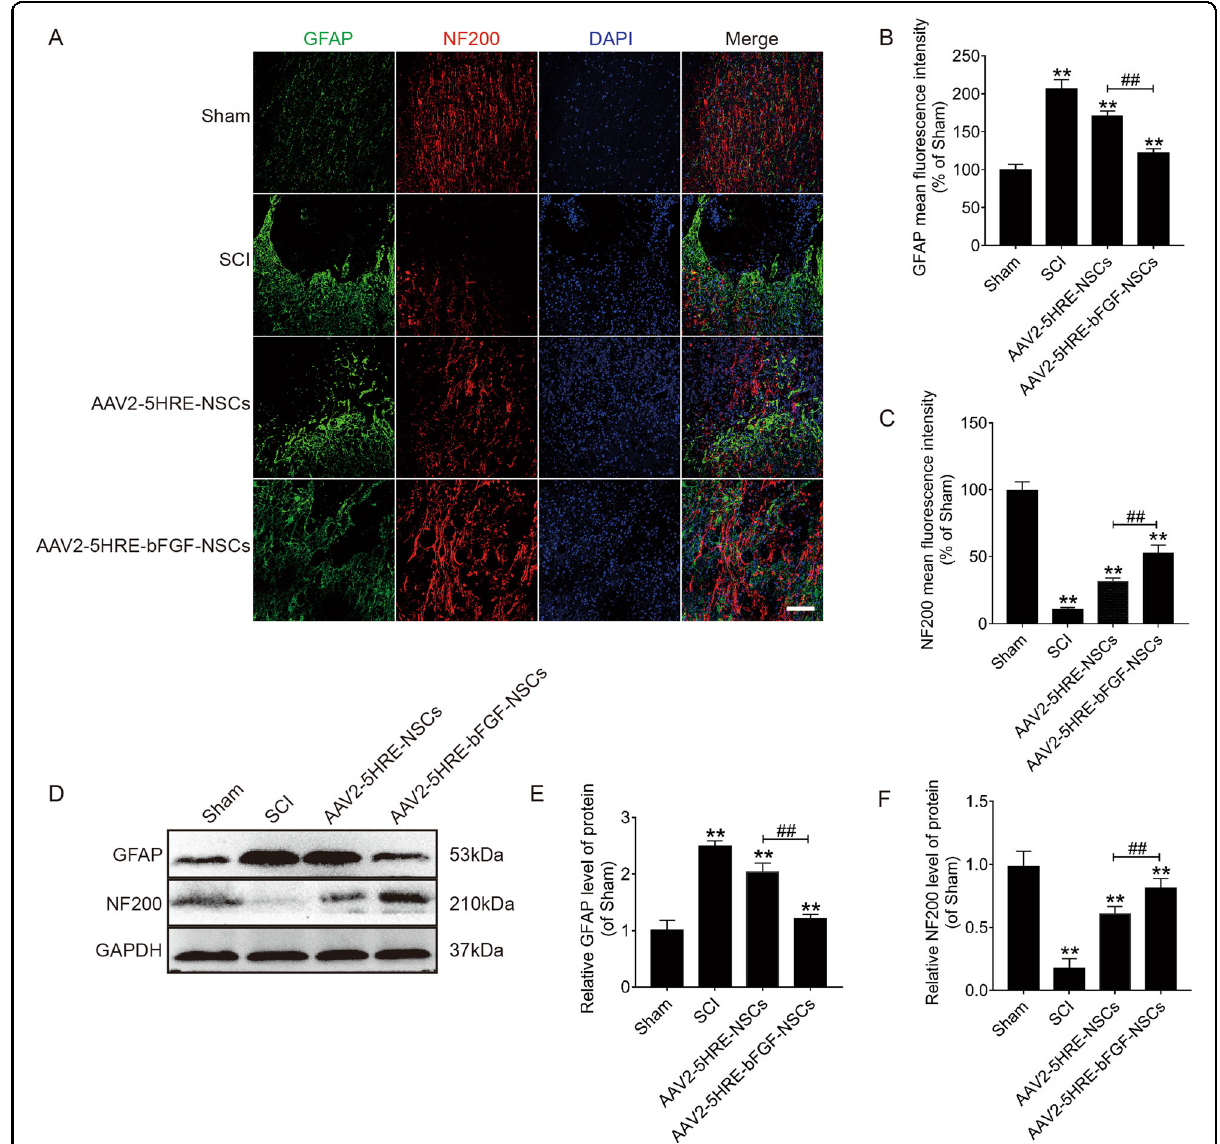
Fig. 6 AAV2-5HRE-bFGF-NSCs increase the expression of neuro fi lament protein NF200 and attenuate the expression of GFAP in SCI rats. A Immuno fl uorescence staining of GFAP and NF200 in sham group, SCI group, AAV2-5HRE-NSCs group and AAV2-5HRE-bFGF-NSCs group. The bright green dots are considered as GFAP positive staining. The bright red dots are considered as NF200 positive staining. The nuclear is labeled by DAPI (blue). Scale bar = 100 µm. B , C Quantitative analysis of GFAP and NF200 fl uorescence intensity results. D – F Western blotting images and quantitative analyses of GFAP and NF200 protein expression levels. GAPDH was used as a protein loading reference. “ ** ” represents P < 0.01, versus the sham group or SCI group. “ ## ” represents P < 0.01, versus the AAV2-5HRE-NSCs group. Data are the mean values ± SEM ( n =